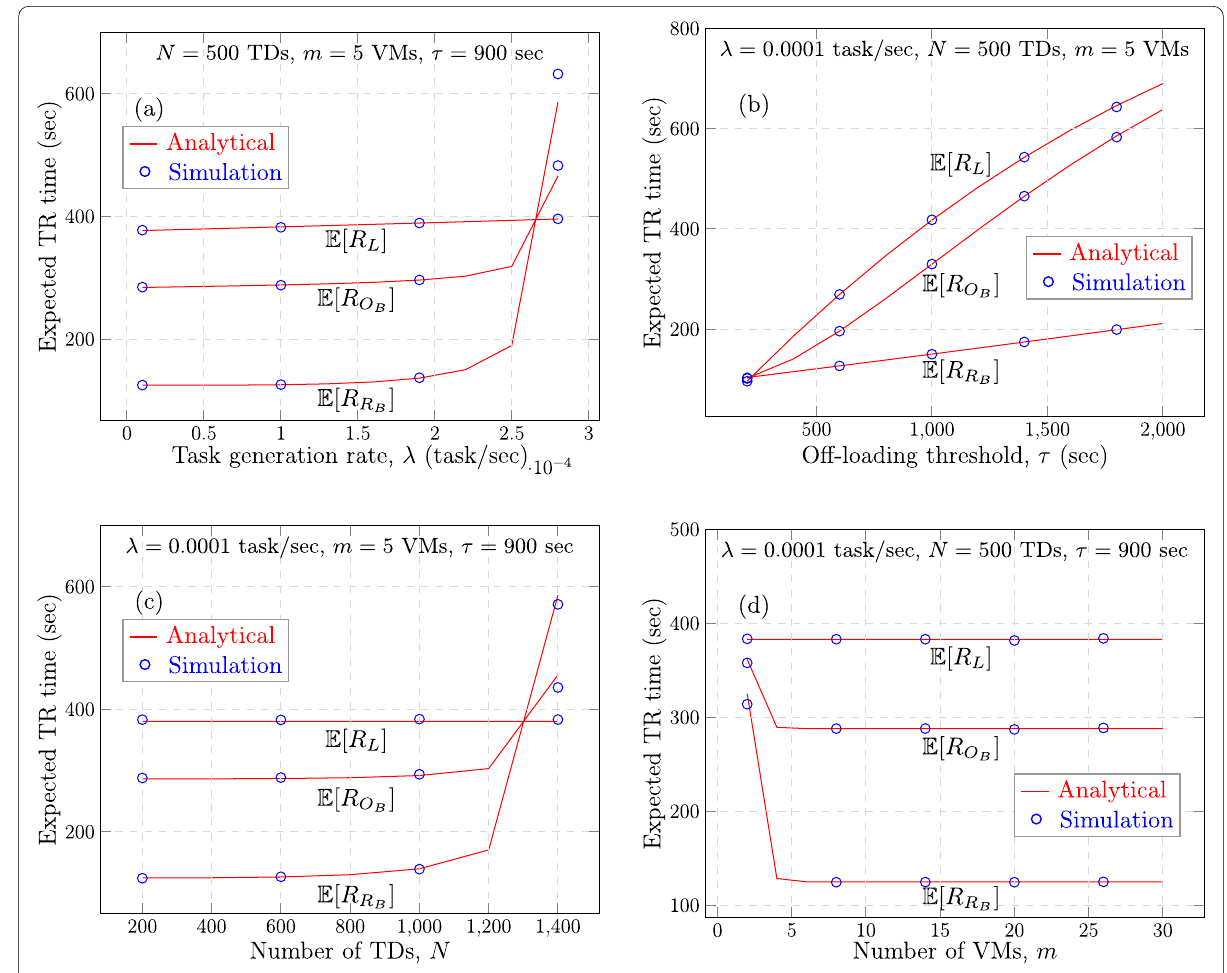
Fig. 6 TR time for the baseline mode, where μ λ . b TR time versus the off‑loading threshold τ . c TR time versus the number of TDs N . d Response times versus the number of VMs